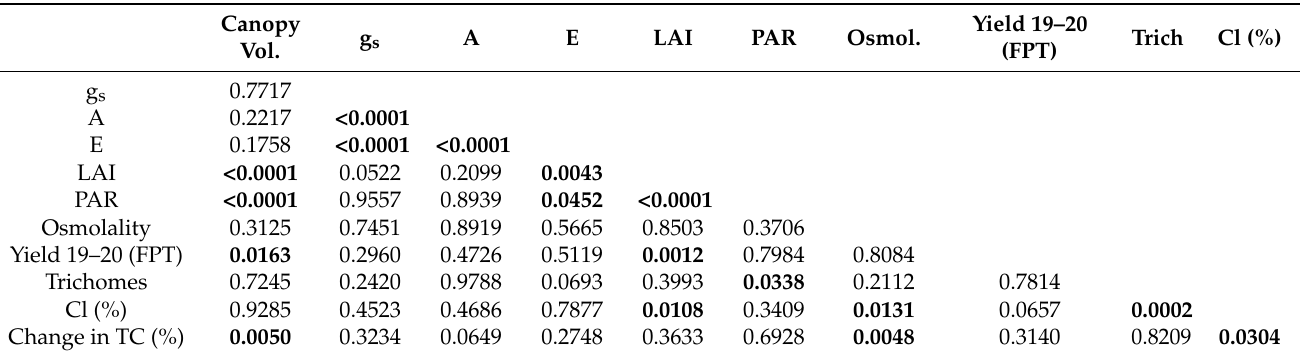
Table 2. Correlation probability between the developmental and physiological indices that were tested among the rootstocks. g s : stomatal conductance. A: CO 2 assimilation. E: transpiration. LAI: leaf area index. PAR: photosynthetic active radiation. Osmol: leaf osmolality. FPT: fruit per tree. Trich: trichomes. TC: trunk circumference. Bold font represents significant ( p ≤ 0.05) correlation between indices.